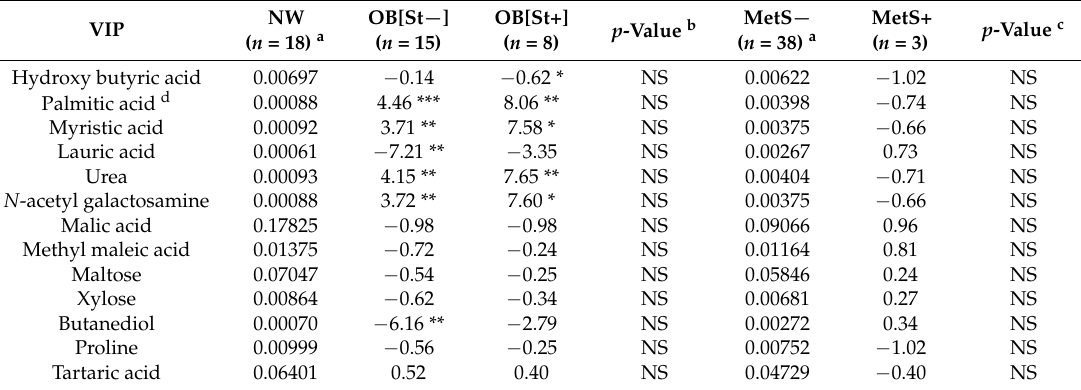
Table 3. Variables important in projection (VIP) metabolites fold changes in patients versus controls’ saliva. NW VIP ( n = 18)